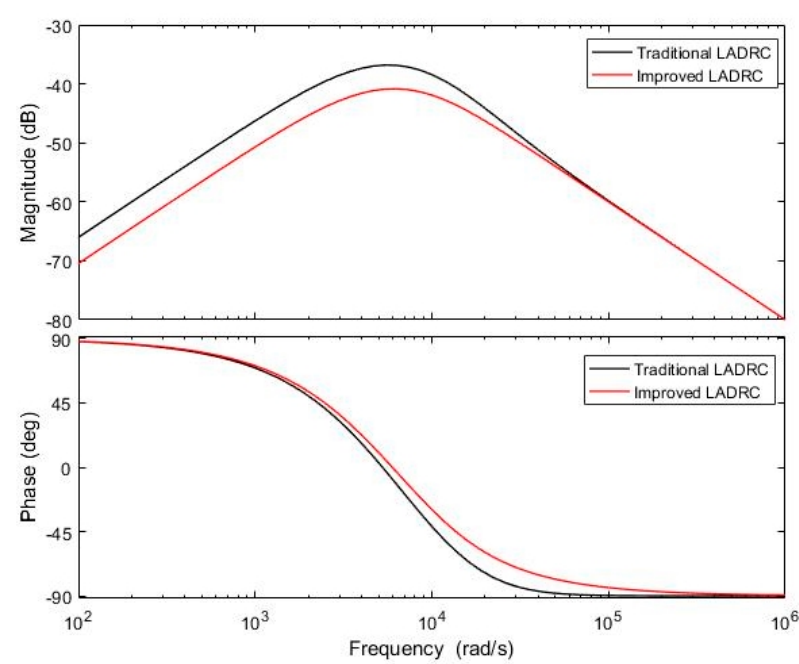
Figure 10. Amplitude phase diagram of the improved LADRC and traditional LADRC.